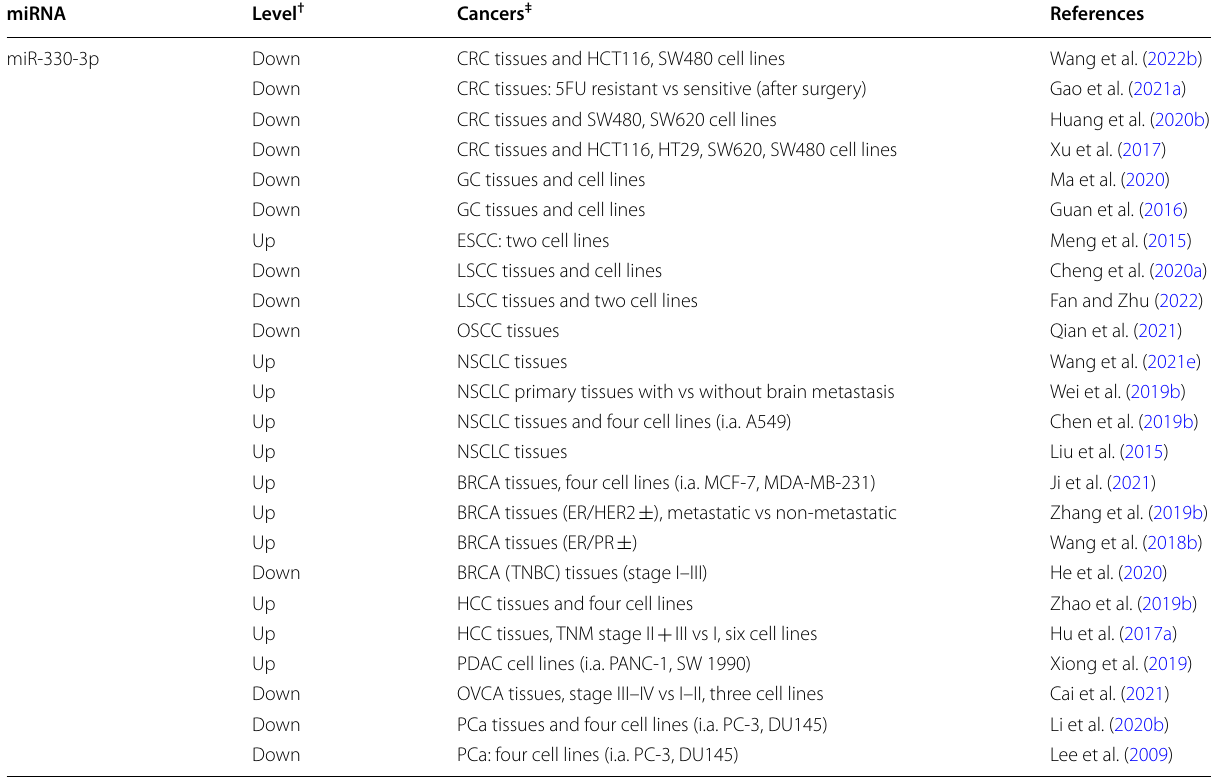
† , ‡ For description see footnote to Table 2